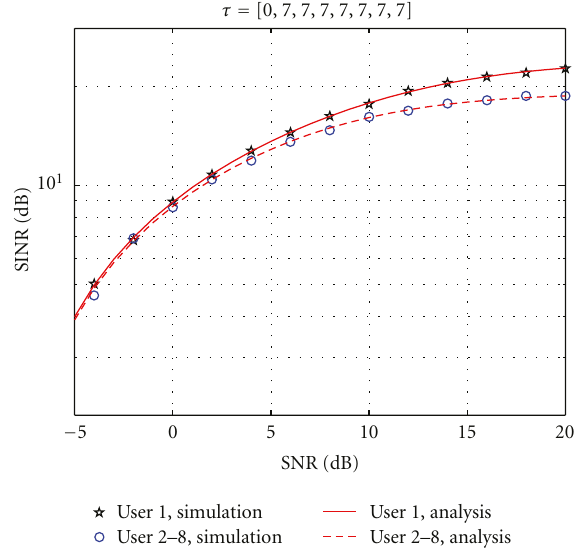
Figure 4: SINR versus SNR, τ 1 = 0, τ 2 = ··· = τ 8 =